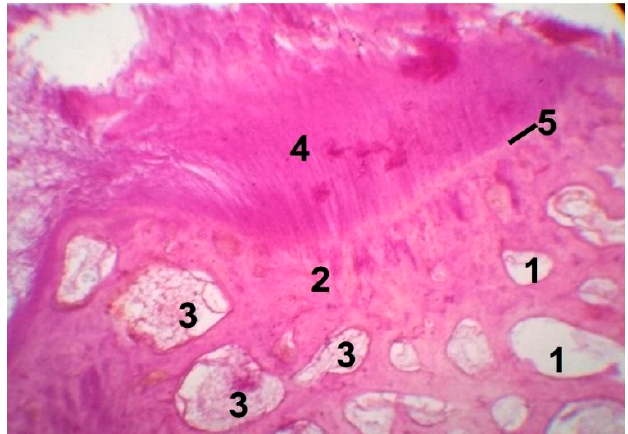
Figure 6. Histopathological sections in cortical area of femur treated with glass powder (experimental group after 3 months, original magnification 10.0×). Legend: 1—the bone marrow vascular niche; 2—old bone; 3—fat inclusions to yellow bone marrow; 4—new bone; 5—the boundaries of bone tissue and bone graft merge (signs of regeneration).